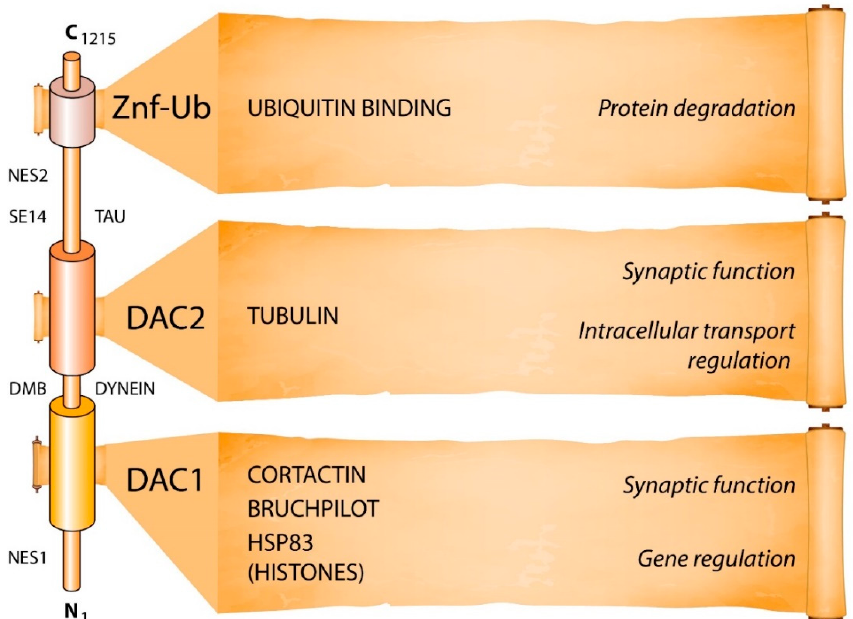
Figure 1. Domains and functions of HDAC6. HDAC6 is the largest protein of the HDAC family, with 1215 amino acid residues. ZnF-UB (zinc-finger ubiquitin binding) is a high-affinity ubiquitin-binding motif, and DAC (deacetylase) (1 and 2) is the domain with deacetylase activity. Targets for DAC1 and DAC2 are based on work largely done in Drosophila [13]. Additional targets include survivin, β -catenin, peroxiredoxin, and Miro1. NES = nuclear export sequences, DMB = dynein motor binding, SE14 = Ser-Glu tetradecapeptide repeating domain [9]. NES1 (Aa: 67–76), DAC1 (Aa: 87–447), DAC2 (Aa: 482–800), SE14 (Aa: 884–1022), NES2 (Aa: 1049–1058), ZnF-UB (Aa: 1131–1192) [9].